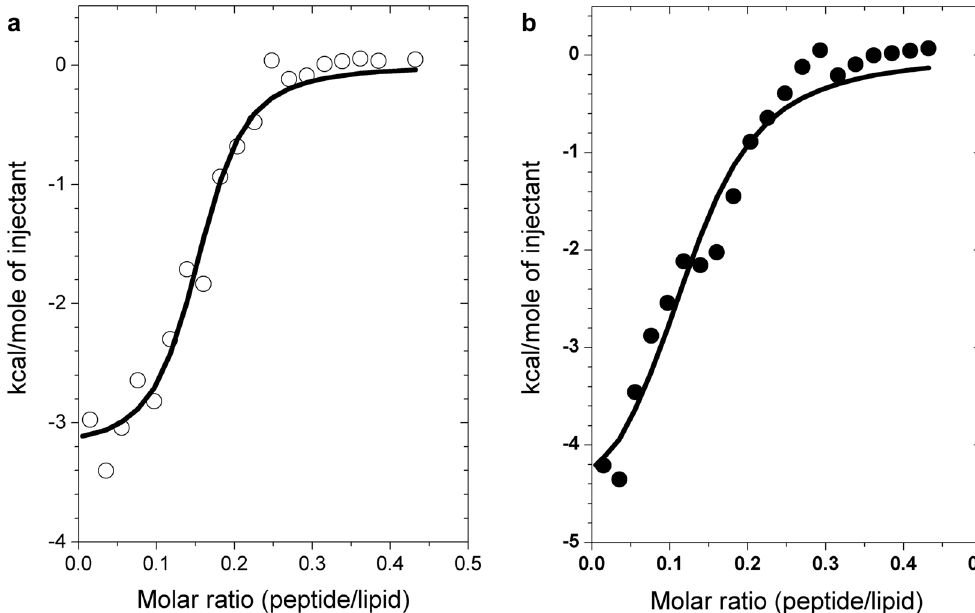
Figure 7. Calorimetric traces for the LPA-peptide interaction. LPA (100 µ M) was titrated with aliquots of the peptide GAP43IQ (200 μ M) under high-salt ( a ) or low-salt ( b ) conditions. Points were fitted to the one set of sites model (solid lines), and parameters evaluated are listed in Table 3.